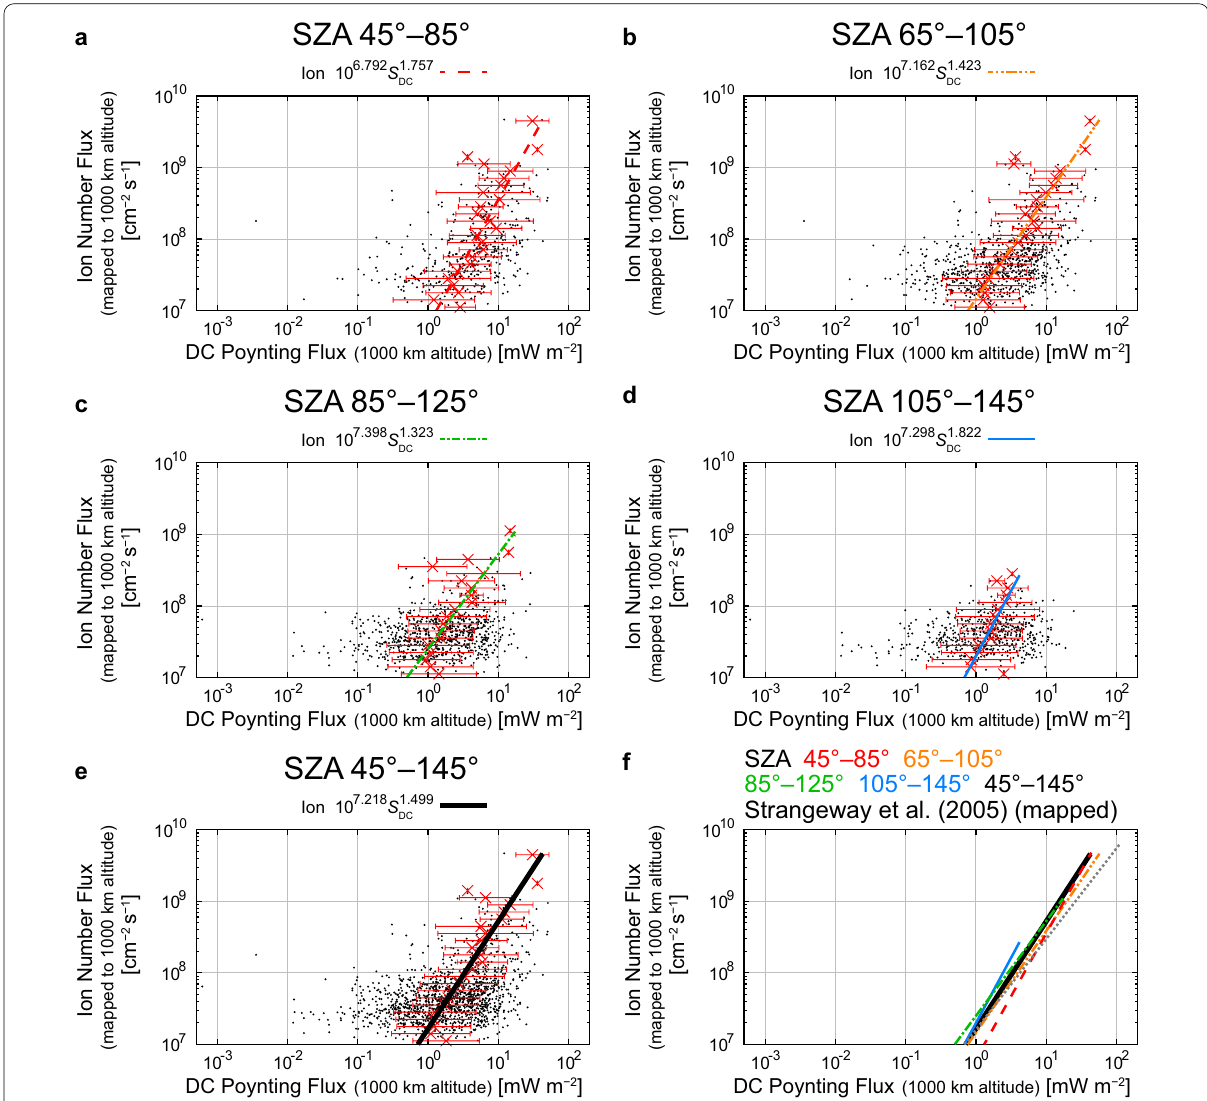
Fig. 5 Relations between the mapped DC Poynting flux (< 0.125 Hz) and the mapped outflowing ion number flux in the SZA ranges of a 45°–85°, b 65°–105°, c 85°–125°, d 105°–145°, and e 45°–145° (all events), and f comparisons among the derived empirical relations in these SZA ranges and the empirical formula derived by Strangeway et al. (2005) (their Eq. 5) (multiplied by a factor of 2.9 to correct for the altitudinal difference of the ion number flux and the DC Poynting flux) (dotted gray line). The format of Fig. 5a–5e is identical to that of Fig. 3a–3d. In Fig. 5f, the empirical relations in the SZA ranges of 45°–145° (all data) are shown using a thick black line, in addition to the format of Fig.